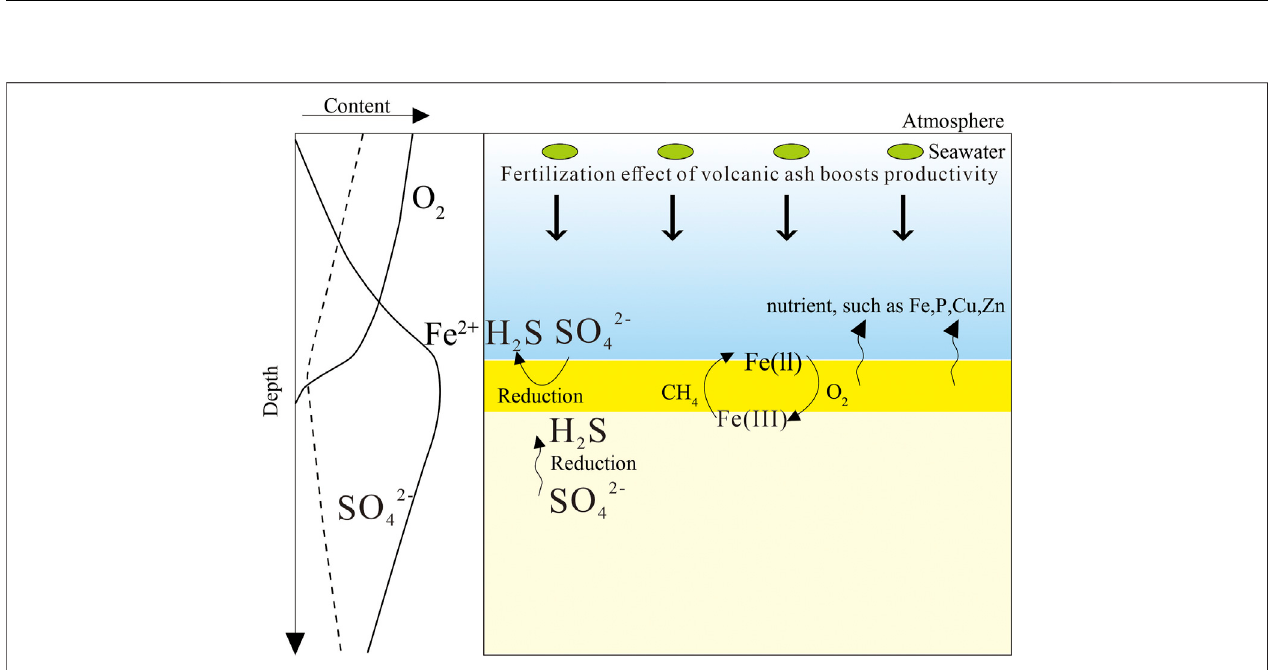
FIGURE10| Schematicelement movement, chemicalreactions,andtheeffectsonproductivity andoxidation-reductionconditionsclosetothevolcanicashlayer.